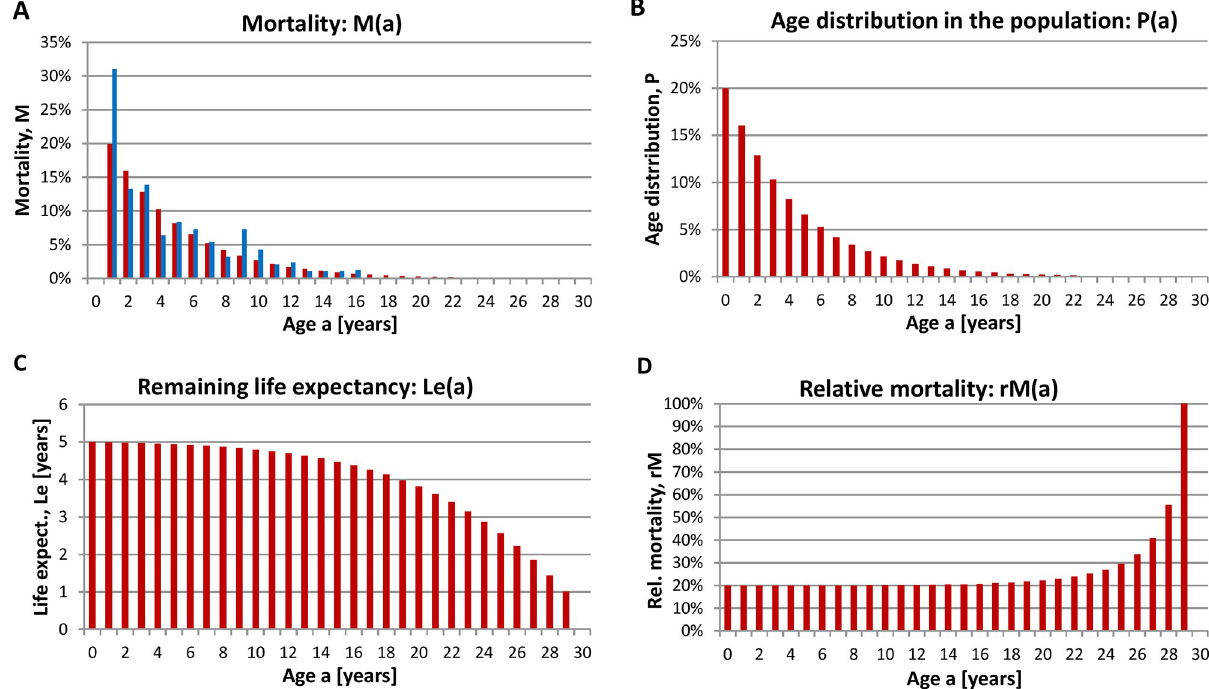
Fig 4. Population dynamics of Black-headed Gulls. (A) Mortality, M(a) (probability of dying at a given age) determined using age-differentiated bird counts (red bars, this study) in comparison to mark-recapture data (351 ring recoveries) as determined by Flegg and Cox [13] (blue bars), (B) age distribution in the autumn population P(a), (C) remaining life expectancy at a given age Le(a), and (D) relative mortality rM(a) (probability of dying when a certain age has been reached) of the Black-headed Gull. Calculations are based on age-differentiated bird counts determined from September— November in Germany (2012–2020, whole country of Germany). Raw data are from the database ornitho . de .